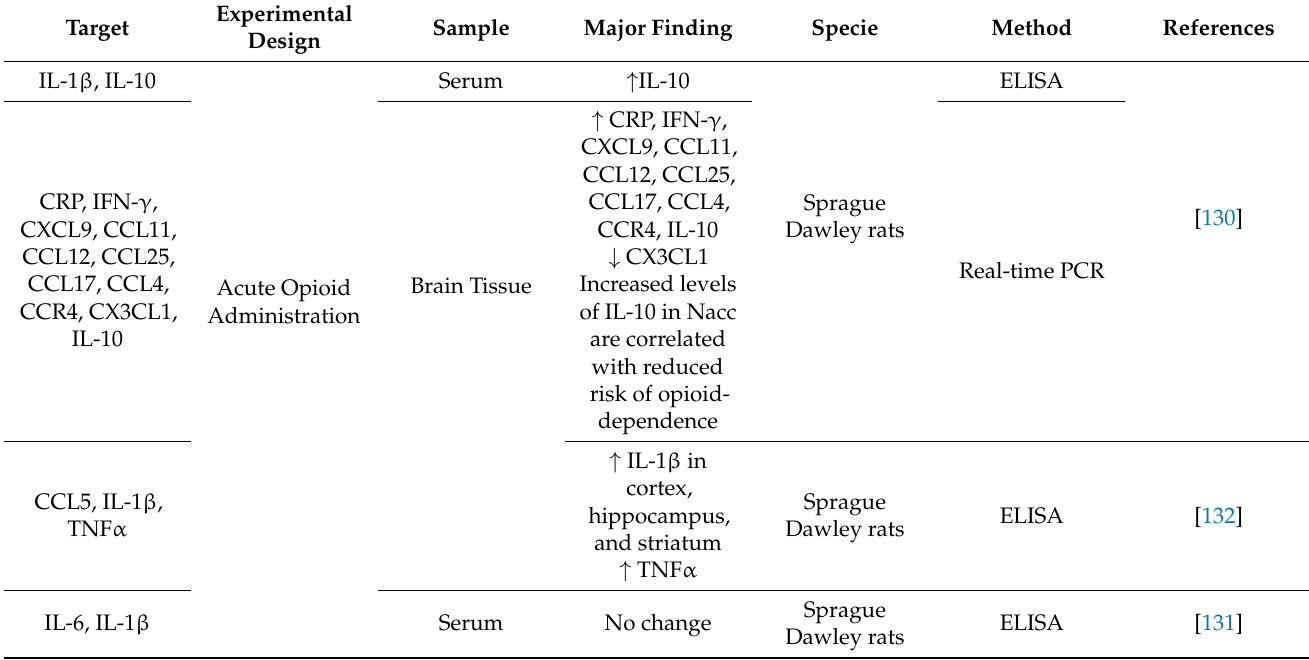
Table 6. Opioid use disorder: Acute Opioid